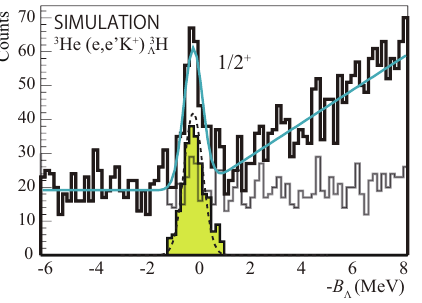
Figure 2. Expected spectrum for the 4 Λ H production in JLab